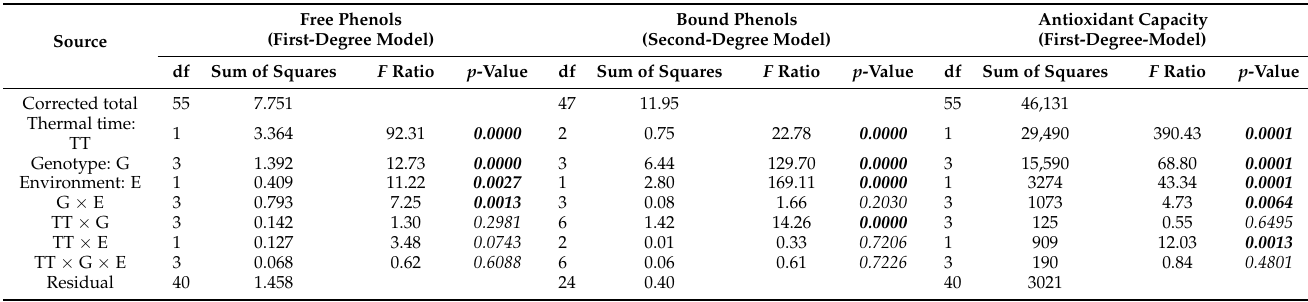
A bold number indicates statistical significance at α <